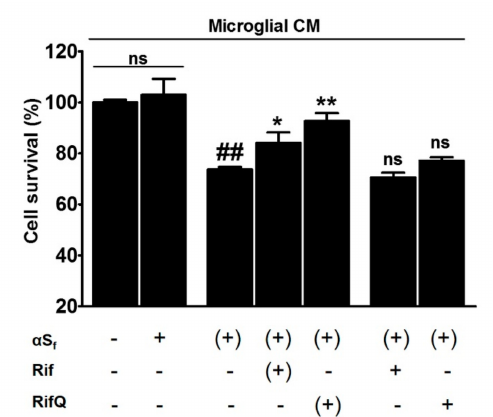
Figure 7. Rif and RifQ attenuate neuronal death caused by microglia activated by α S f . Cortical neurons were cultured for 48 h in the presence of microglial conditioned medium (CM) obtained as described in the text. ( + ): Indicates that the treatment was supplied initially to microglial cultures, and was thus provided indirectly to neuronal cultures through CM. The CCK-8 assay was used to evaluate neuronal viability. Data represent means of three di ff erent experiments performed in triplicate and error bars show SEM. Results are expressed as percentage of control values in cortical cultures receiving CM from control microglial cultures. Note: ## p < 0.01 vs. control CM; * p < 0.05, ** p < 0.01 vs. α S f -treated CM; ns = not significantly di ff erent from α S f -treated CM.